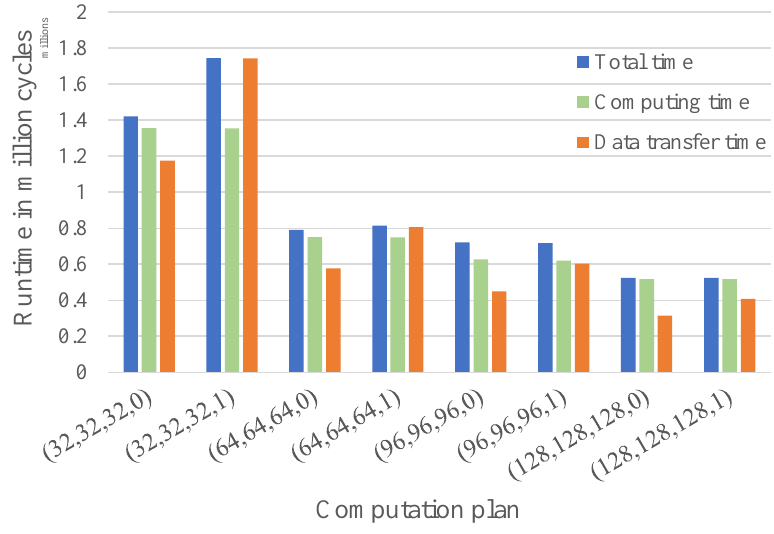
Figure 11. The time cost of GEMM under different computation schemes.